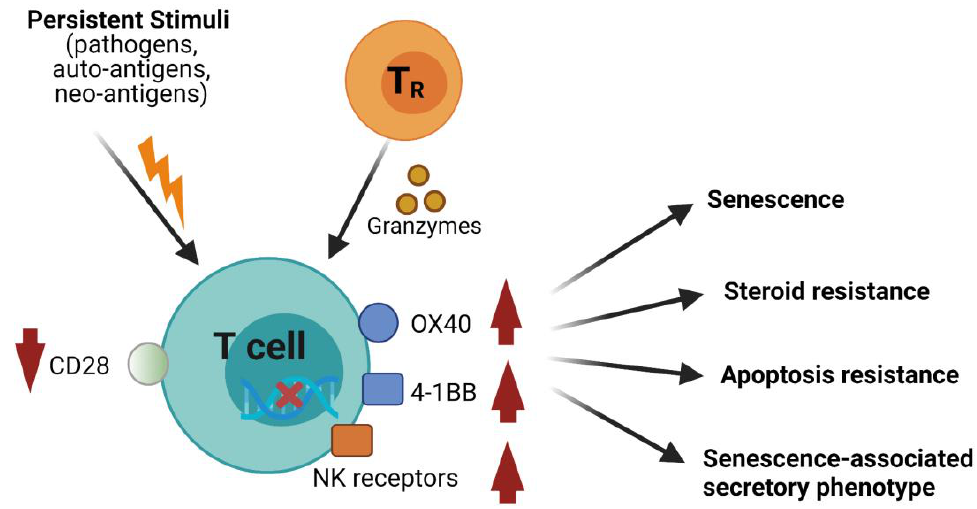
Figure 1. Molecular characteristics of CD28 null senescent T-cells. Persistent stimuli from various chronic conditions and/or chronic conditions and/or interaction with regulatory T (T R ) cells lead to a senescent phenotype of interaction with regulatory T (T R ) cells lead to a senescent phenotype of effector T-cells (see T R -mediated senescence in effector T-cells (see T R -mediated senescence in “Mechanisms underlying CD28 null cells-associated “Mechanisms underlying CD28 null cells- associated adverse consequences” below). These senescent T -cells down-regulate adverse consequences” below). These senescent T-cells down-regulate costimulatory molecule costimulatory molecule CD28 and express increased levels of surface molecules, OX40, 4-1BB and NK-like receptors. Be- cause of accumulation of DNA damage and alteration of metabolic and epigenetic programs, these cells largely lose their proliferation ability. These cells are resistant to apoptosis and steroid treatment and gain a senescence-associated secretory phenotype (SASP).